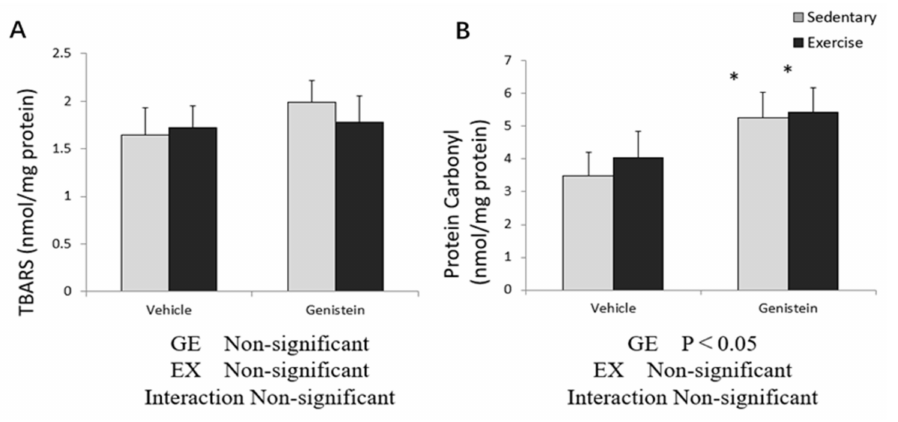
Figure 8. ( A ) Liver TBARS (Con, n = 7; GE, n = 7; Ex, n = 8; GE + EX, n = 8); ( B ) protein carbonyl (Con, n = 8; GE, n = 7; Ex, n = 8; GE + EX, n = 8), vehicle: non-supplemented groups (only administrated with 0.5% CMC-Na solution); GE: GE-supplemented groups. * p < 0.05, main effect for GE treatment. Values are means ±